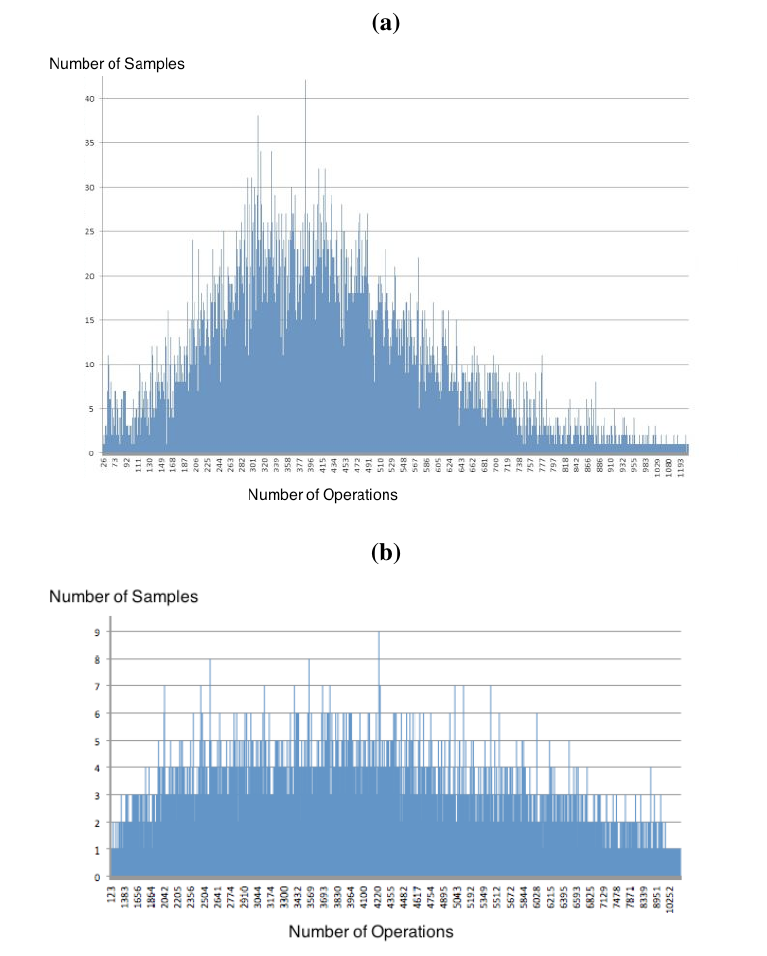
= 5 ). ( a ) Distribution found for n = 5 n